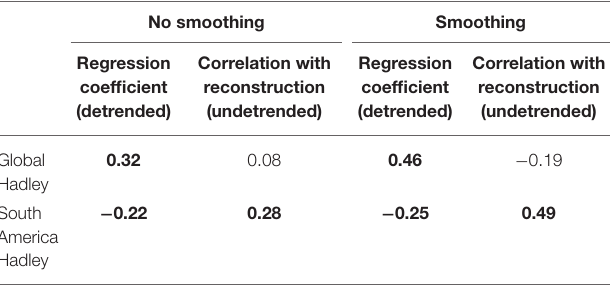
TABLE 4 | Regression Coefficient between detrended Hadley displacements and detrended U200 anomalies, and correlation between undetrended Hadley displacement and U200 anomalies, for both no-smoothed and smoothed (with 5-year moving average) normalized